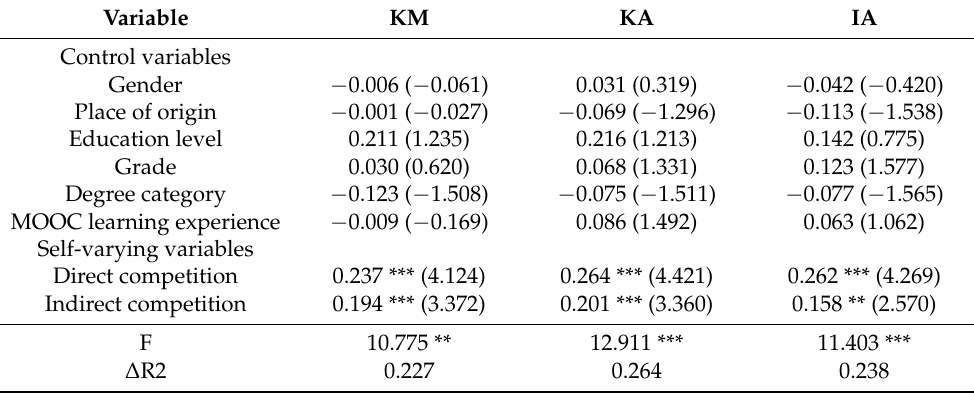
Table 1. Correlation regression analysis between competition and learning